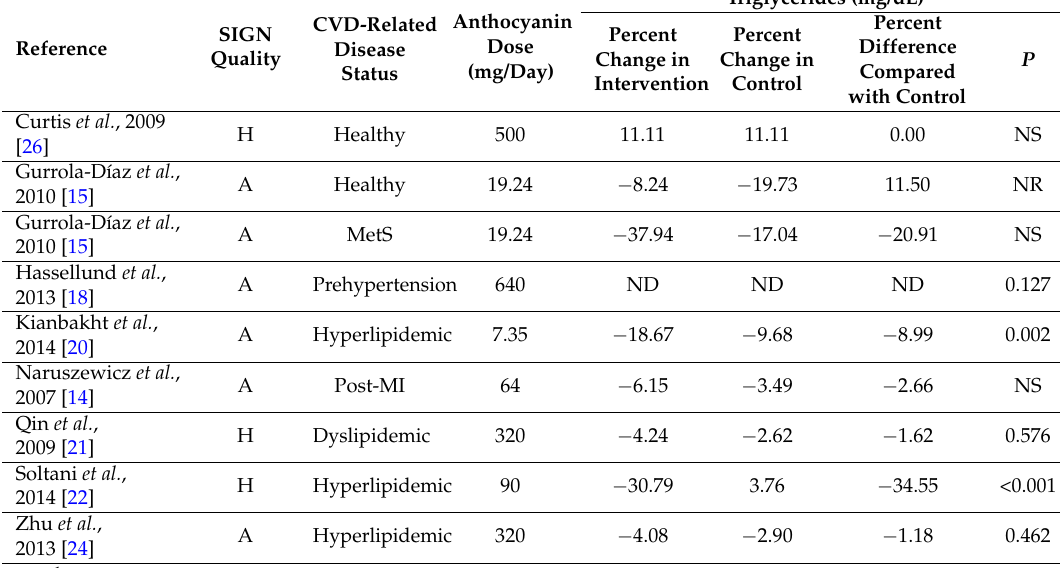
Table 3. Triglycerides 1